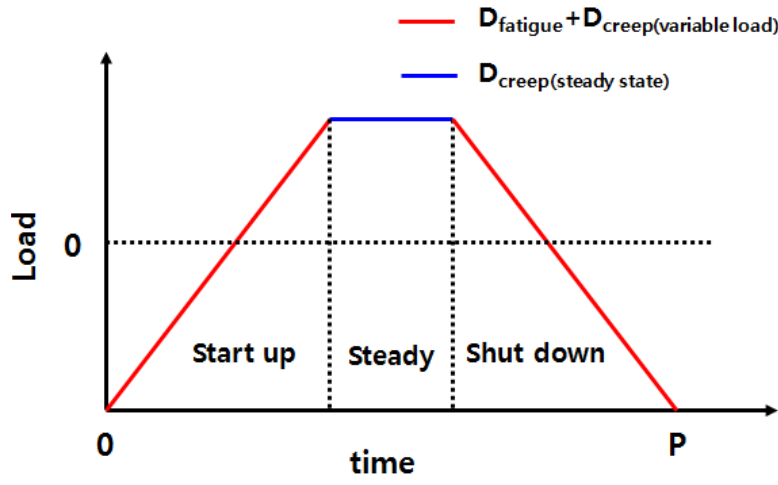
Figure 6. Types of damage with respect to the operating conditions.